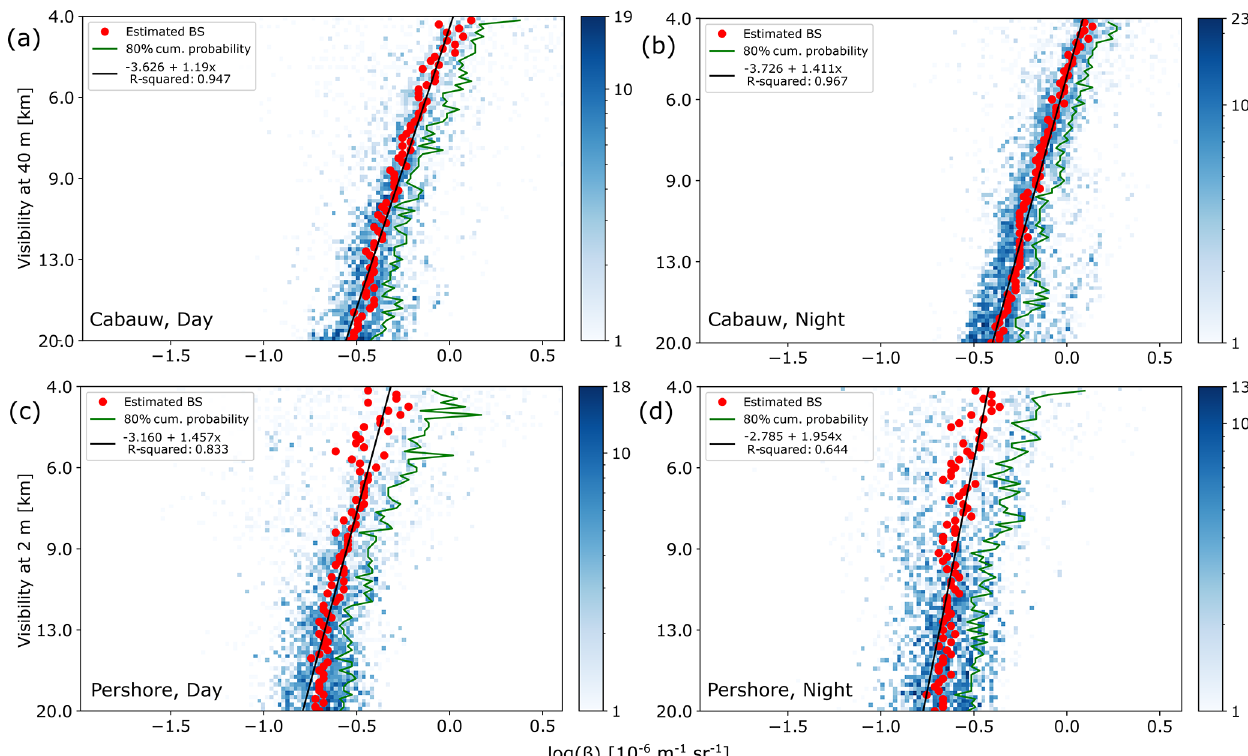
Figure 13. Comparison of 2D histograms between day and night at 39m lidar probe height. (a) Cabauw, day. (b) Cabauw, night. (c) Pershore, day. (d) Pershore, night. To account for the reduced sample size, the threshold was reduced to µ +